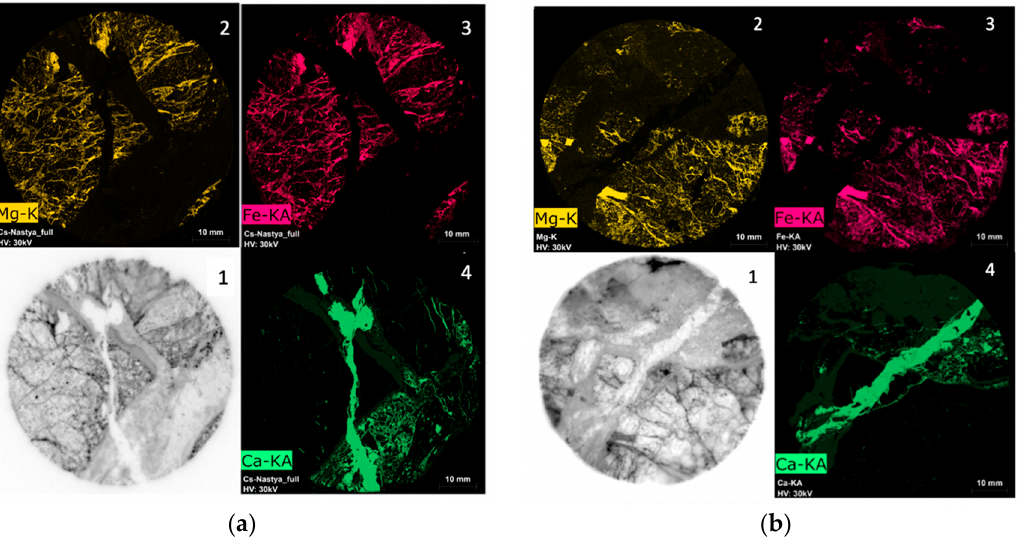
Figure 5. 1: radiograms of cesium ( a ) and strontium ( b ) sorption on the sample R-11 (disc 1 and 2, respectively); 2, 3: elemental maps of Mg and Fe distribution on the surface of R-11 sample (chlorite identifying); 4: elemental map of Ca distribution (calcite identifying).